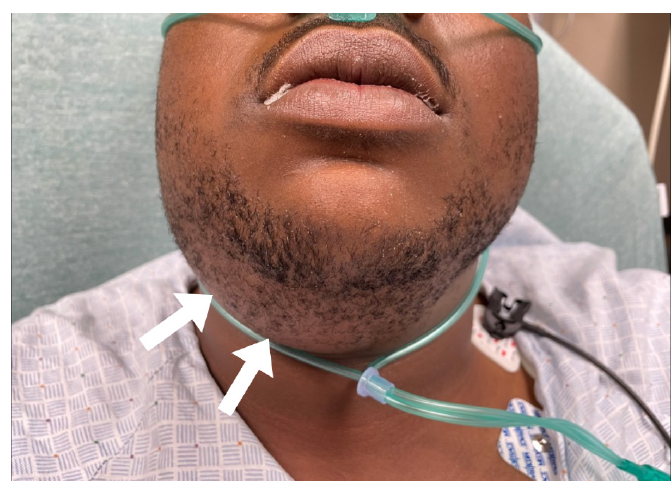
Image 1 . Photograph of patient’s lower jaw and neck demonstrating sublingual and submandibular swelling